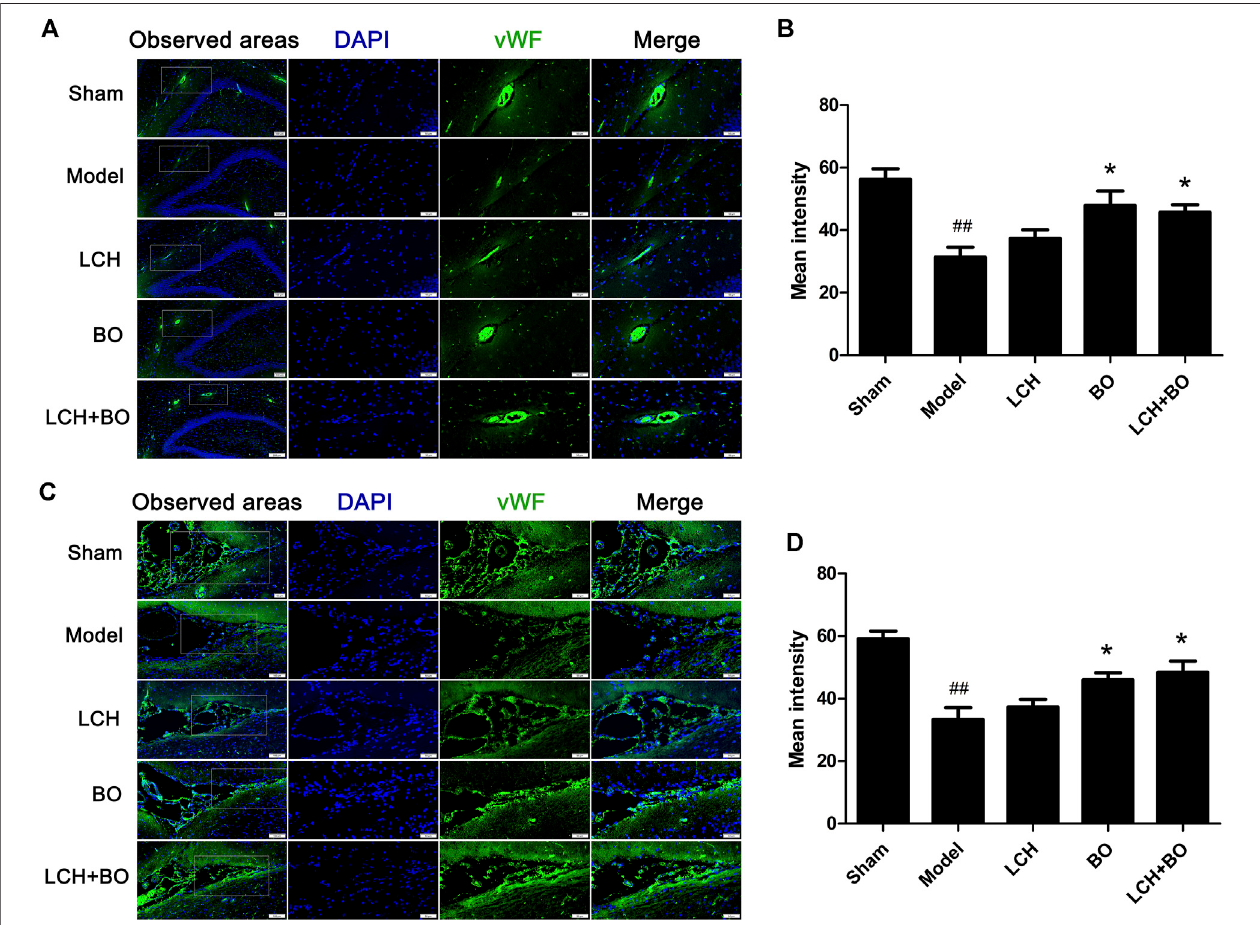
FIGURE 9 | Expressions of vWF within DG and SVZ of MCAO rats. (A) Representative immunostaining images of vWF in the DG area. (B) The results of average fl uorescence intensities of vWF in the DG area ( n (cid:1) 3). (C) Representative immunostaining images of vWF in the SVZ area. (D) The results of average fl uorescence intensities of vWF in the SVZ area ( n (cid:1) 3). ## p < 0.01 compared to the sham group; * p < 0.05 compared to the model